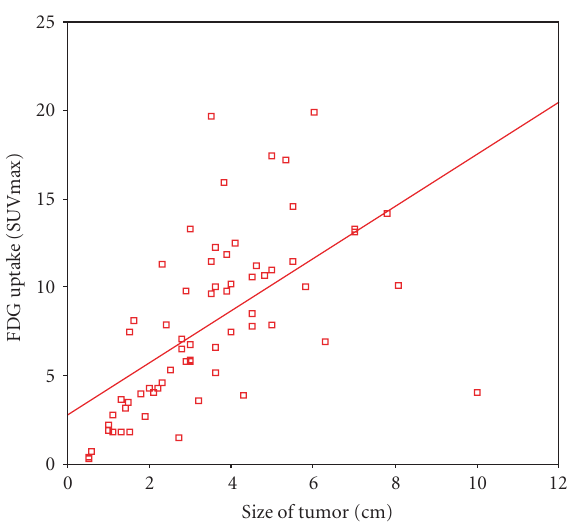
Figure 1: The correlation between FDG uptake and the sizes of 59 malignant tumors.